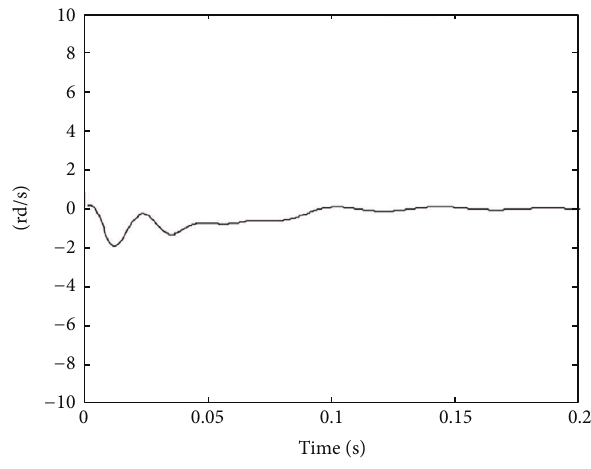
Figure 15: Rotor speed estimation